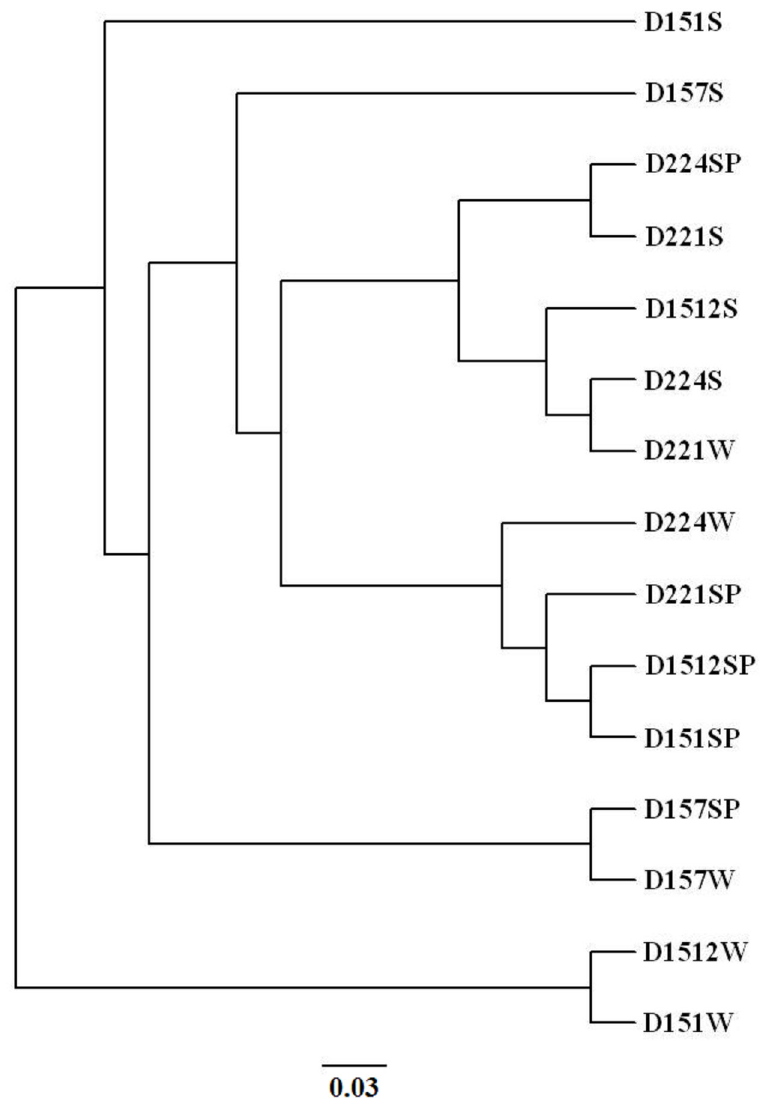
Figure 5. UPGMA cluster of the samples collected from the five locations in spring, summer and winter at OTU definition of